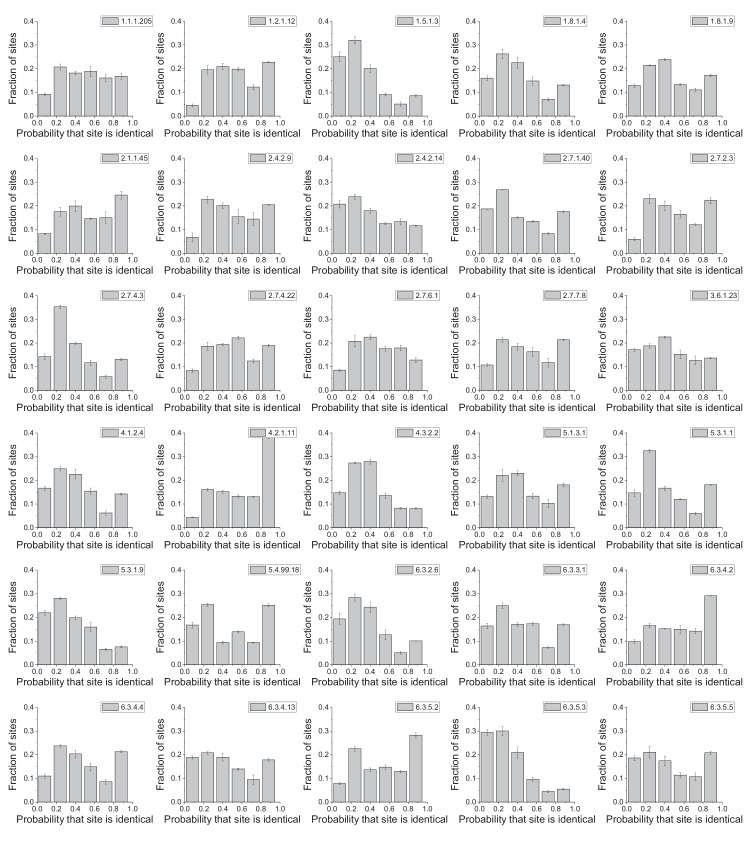
Distribution of enzyme sites according to their conservation frequency.The panels show the distribution of protein sites according to their probability of being identical in phylogenetically independent lineages; the distributions are shown for 30 different enzyme activities (EC numbers). The probabilities were calculated as the proportion of phylogenetyically independent pairs of orthologs, with divergence times > 2 billion years (Figure 2a), in which a protein site is occupied by identical amino acids. Error bars represent the S.E.M across three replicates with different assignments of independent orthologous pairs.